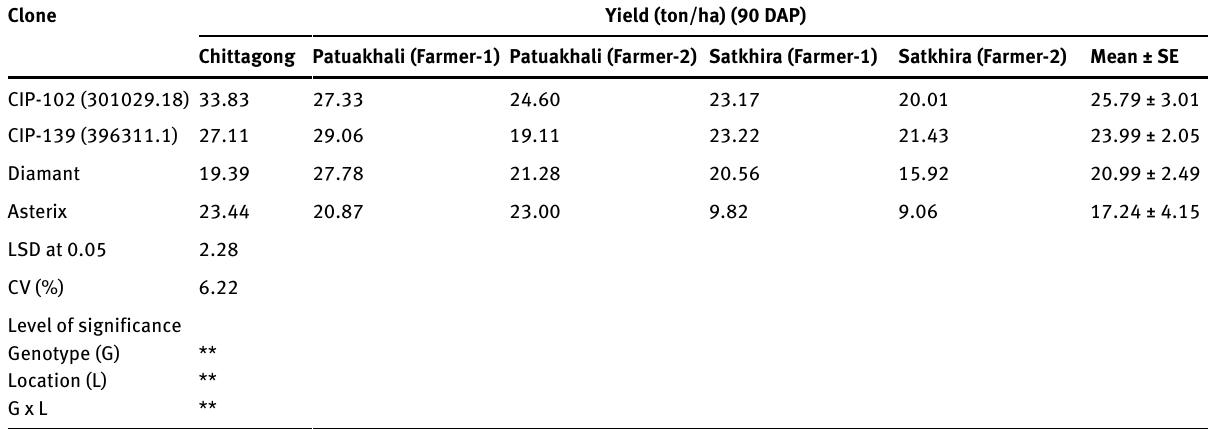
Table 5: Yield performance of 2 CIP promising potato clones and in check varieties at farmers’ fields at Chittagong (1), Patuakhali (2) and Satkhira (2) in Bangladesh during 2014-15 crop